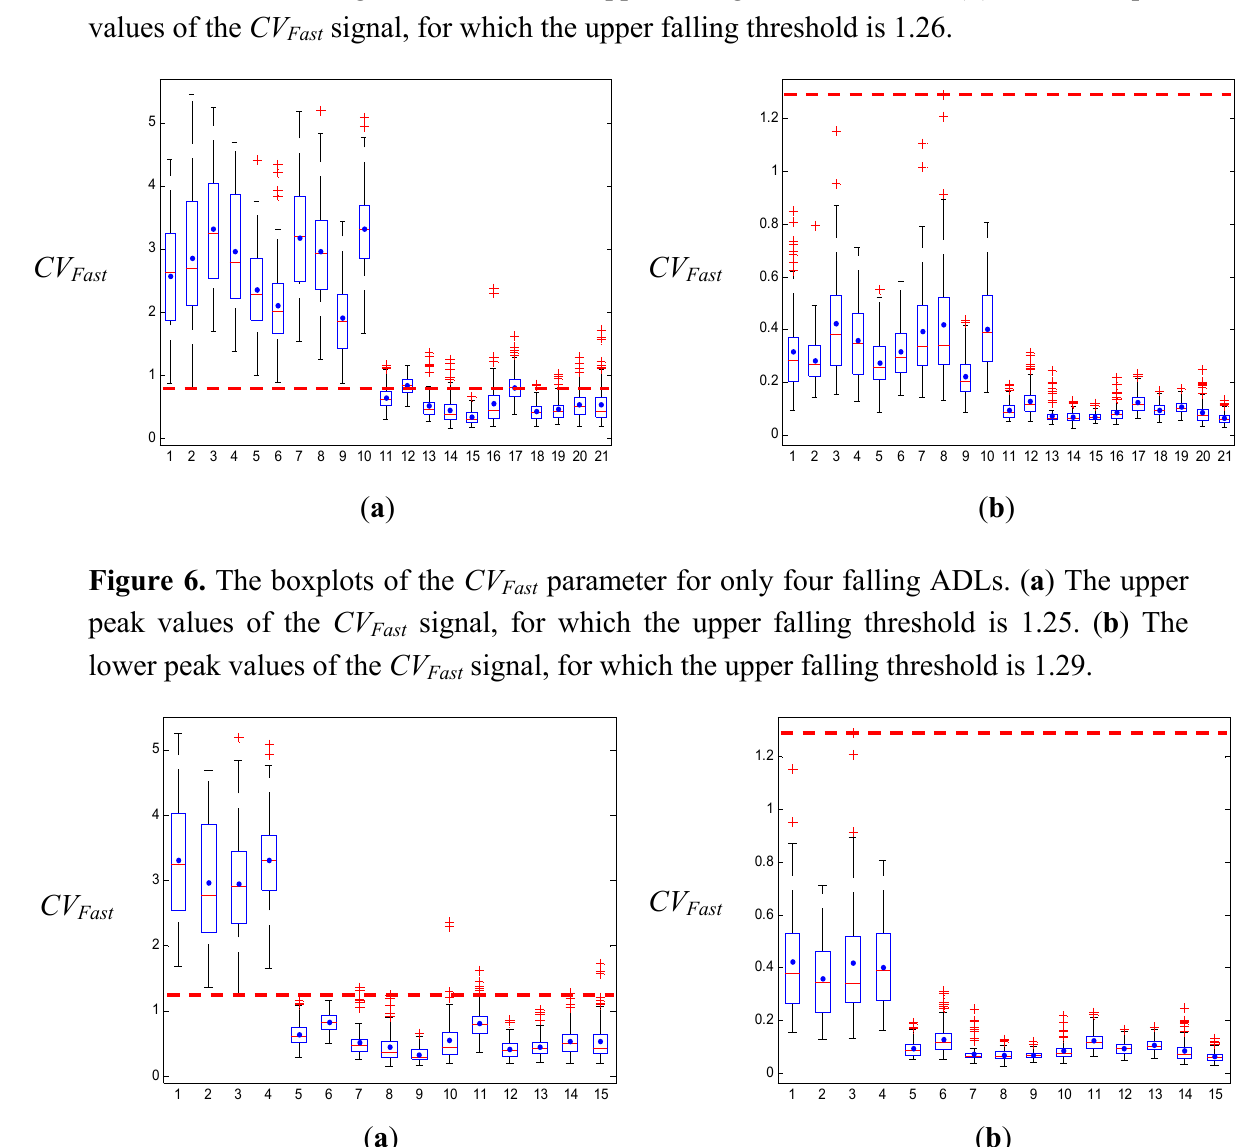
parameter for all of the ADLs. ( a ) The upper peak Figure 5. The boxplots of the CV Fast signal, for which the upper falling threshold is 0.8. ( b ) The lower peak values of the CV Fast signal, for which the upper falling threshold is 1.26. values of the CV Fast